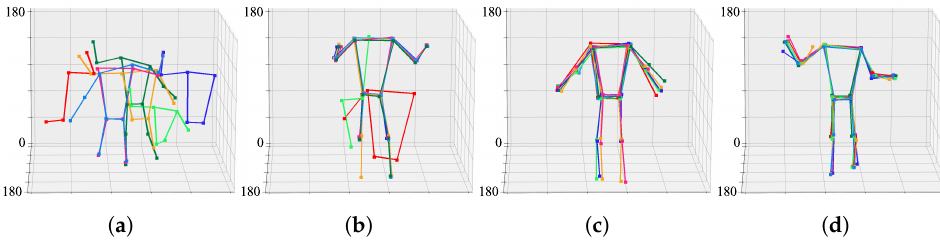
Figure 12. Progress of calibration and 3D joint set estimation according to frame. Each raw corre- sponds to a view-point of a 3D model. ( a ) initial joint sets, ( b ) joint sets in the 18th frame, ( c ) joint sets in the 73rd frame, ( d ) joint sets in the 74th frame.